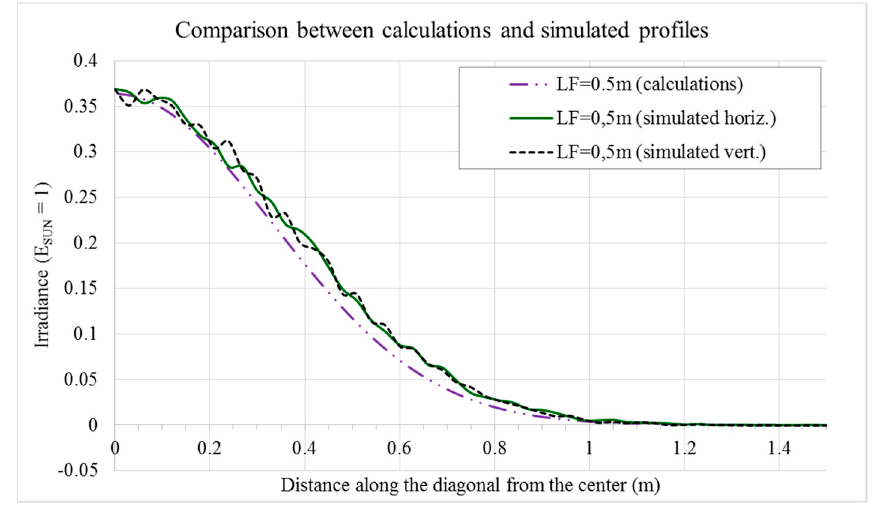
Figure 5. Comparison between simulated and calculated irradiance profiles for L F 0.5 m.